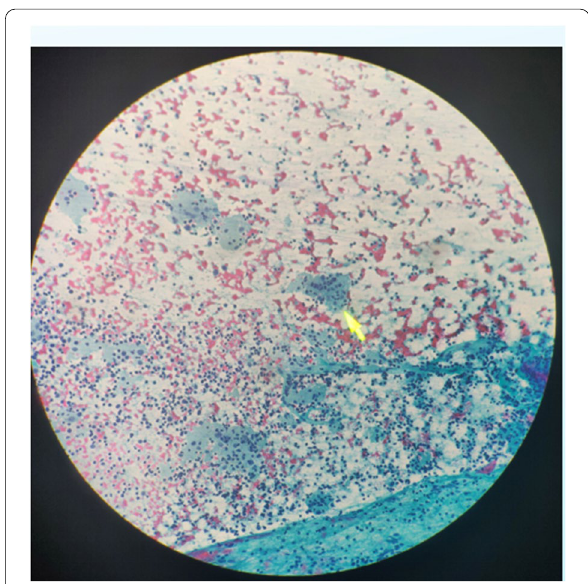
Fig. 4 Histopathology slide showing emperipolesis—foamy histiocytes in emperipolesis form, there was mixed population of small and large lymphocytes with few plasma cells and neutrophils